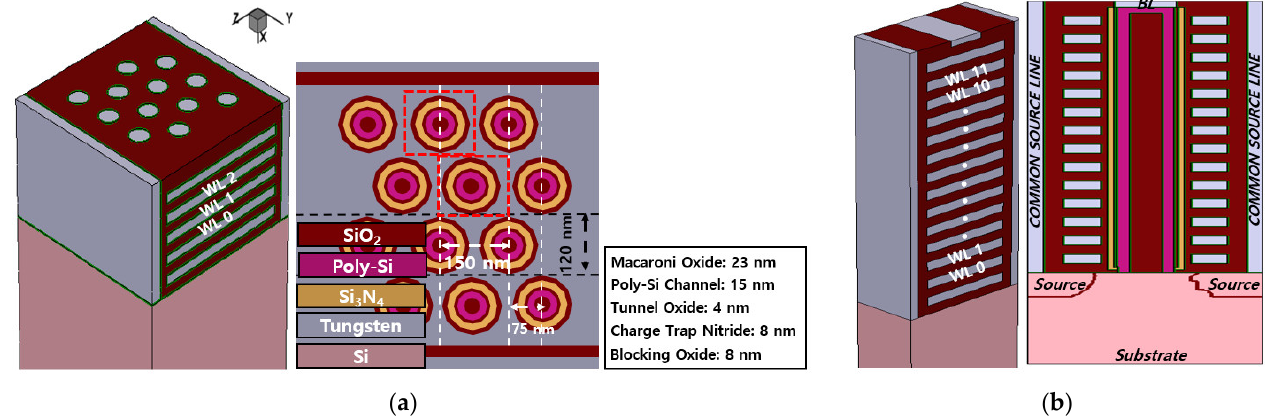
Figure 1. 3D NAND model used for stress simulation and material parameters. 3D simulation model of 3D NAND used in ( a ) the stress simulation and ( b ) the stress-induced electrical characteristics variation simulation.